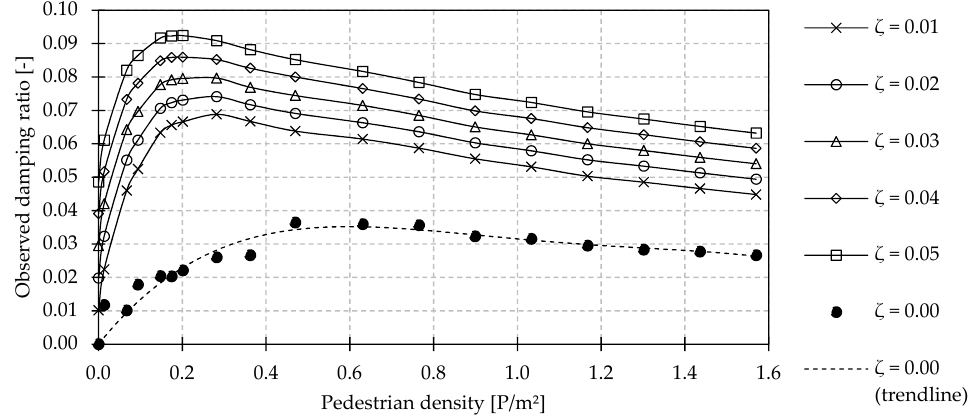
Figure 4. Calculated damping ratio as a function of pedestrian density.